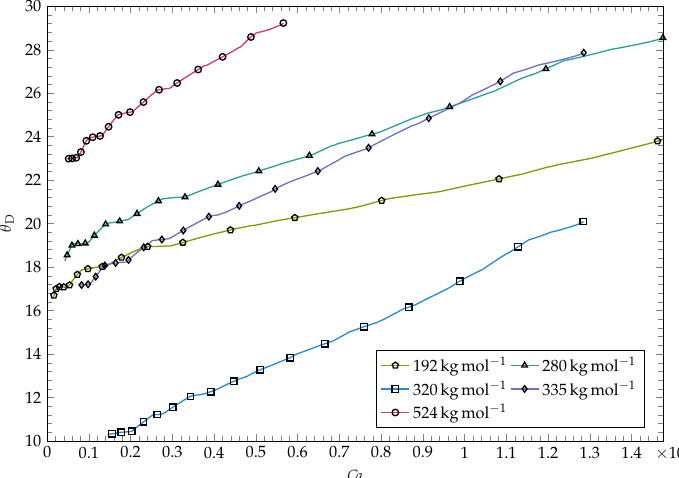
Figure 5. Dynamic contact angle over capillary number during late stage spreading. Ca is calculated with the initial material properties of pure